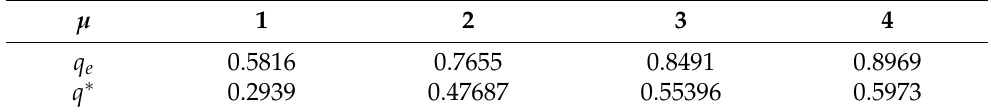
Table A1. Comparison of q e and q ∗ values against energy-harvesting rate µ .